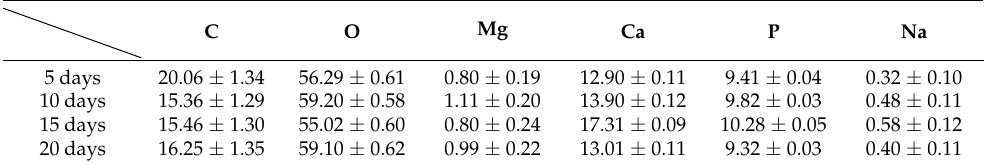
Table 7. Variation of elements contents of the coating over immersion time (at.%).